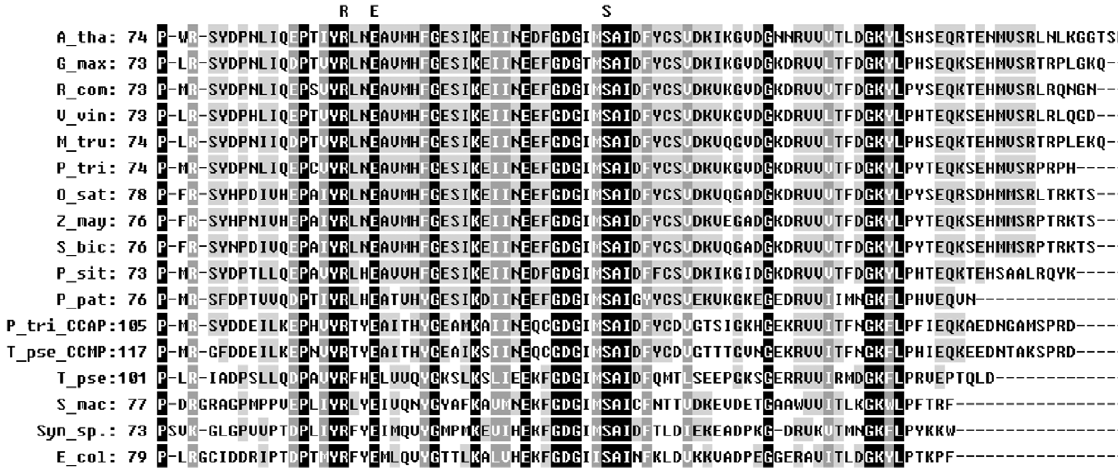
Figure 1. Alignment of catalytic regions of cyanases from fungus, plant and bacterial species. Accession numbers for each cyanase are listed in Table 1. Residues conserved in all sequences are indicated in white type on a black background, the consensus residue or similar residues in all sequences are indicated in white type on a dark grey background and the consensus residue or similar residues in the sequences of cyanases from Dicotyledoneae and Monocotyledoneae are indicated in black type on a light grey background. The predicted catalytic residues in E. coli are indicated above the alignment.